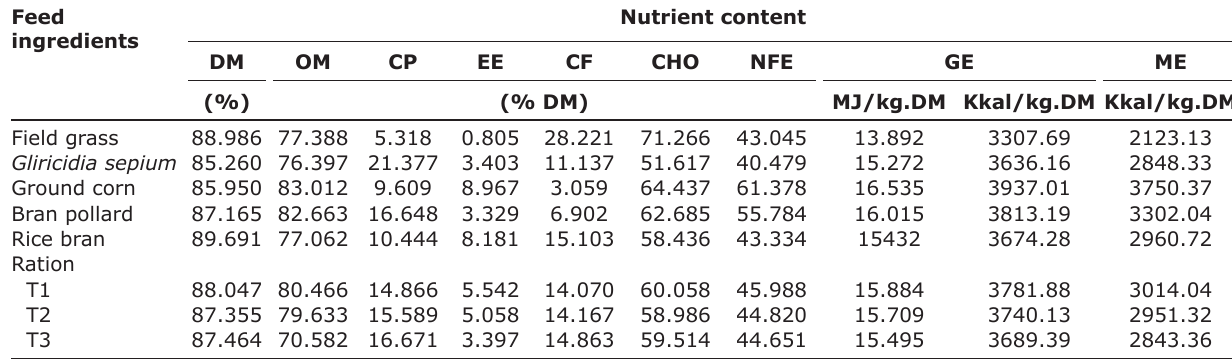
Table-1: Nutrient content of feed ingredients composition and ration of complete feed for Bali cattle fattening. Feed ingredients